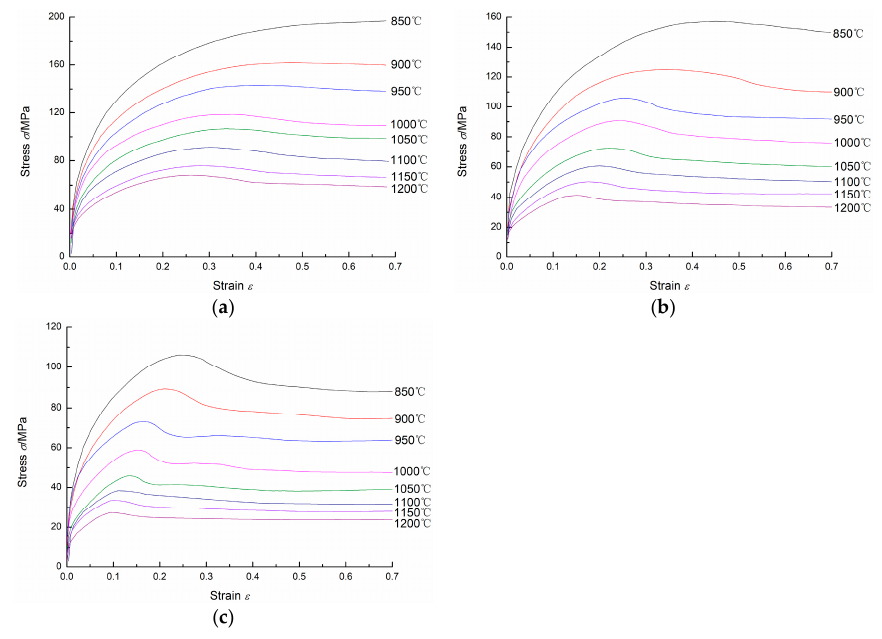
Figure 2. Flow stress curves of the 20Mn5 steel under strain rates of: ( a ) 1/s; ( b ) 0.1/s; ( c ) 0.01/s.